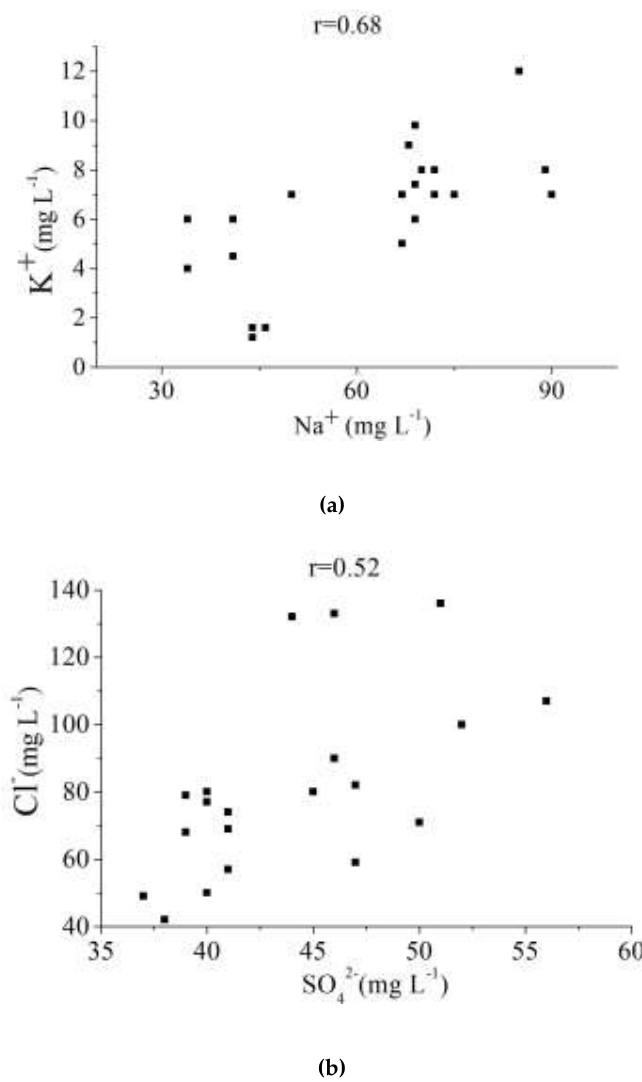
Figure 8. Relationships between Na + and K + , and SO 4 2 − and Cl − ( a ) Correlation between Na + and K + . ( b ) Correlation between SO 4 2 − and Cl − .